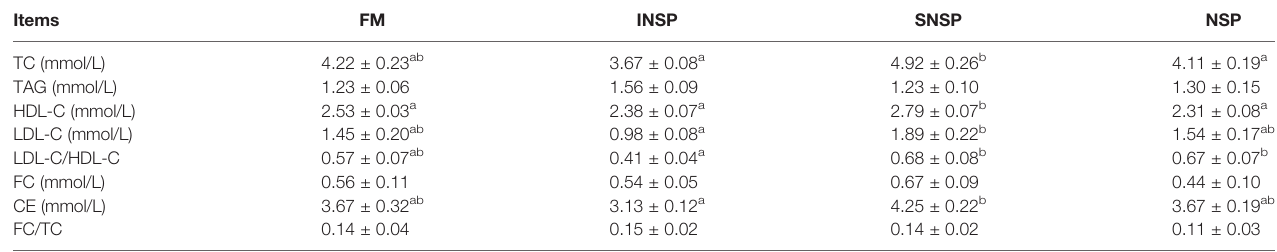
TABLE 4 | Serum lipoprotein pro fi le of GIFT tilapia fed diets with different types of non-starch polysaccharides. Items